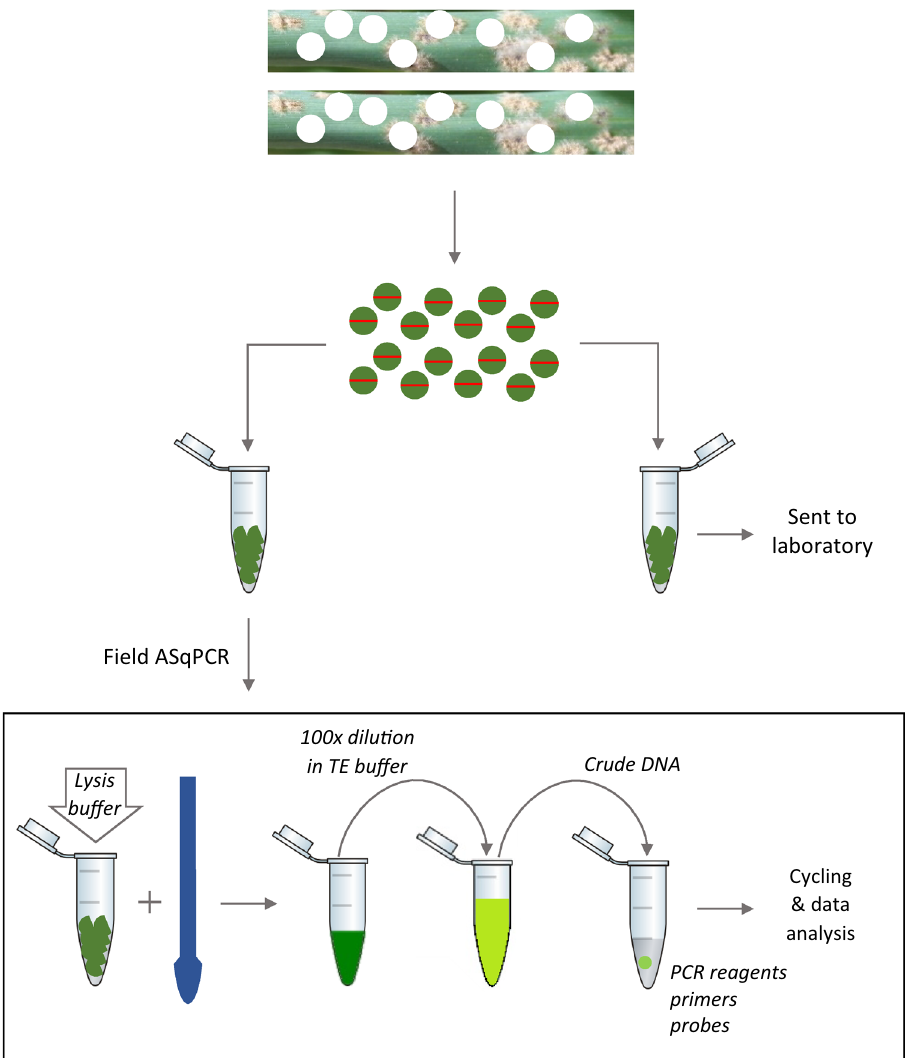
Figure 6. Schematic representation of the procedure followed in the field for the extraction of